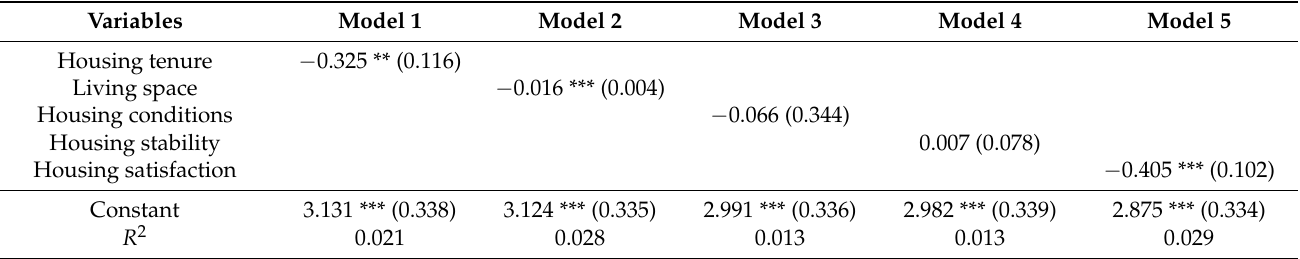
Table 3. Regression results of housing status and stress.